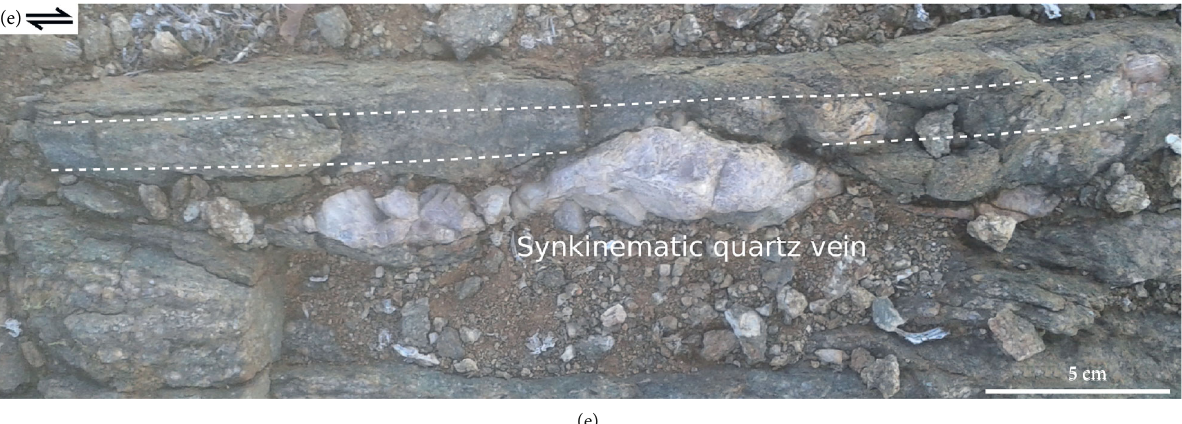
Figure 4: Outcrop pictures of (a) the core region of the sampled high-strain zone in area D, including a representative (green) zone enriched in chlorite and epidote; (b) gradual but sharp transition from mylonite to ultramylonite; (c) reshearing of fold limbs in the migmatitic biotite gneiss in area D; (d) representative (pink) sample enriched in feldspar; (e) representative synkinematic quartz